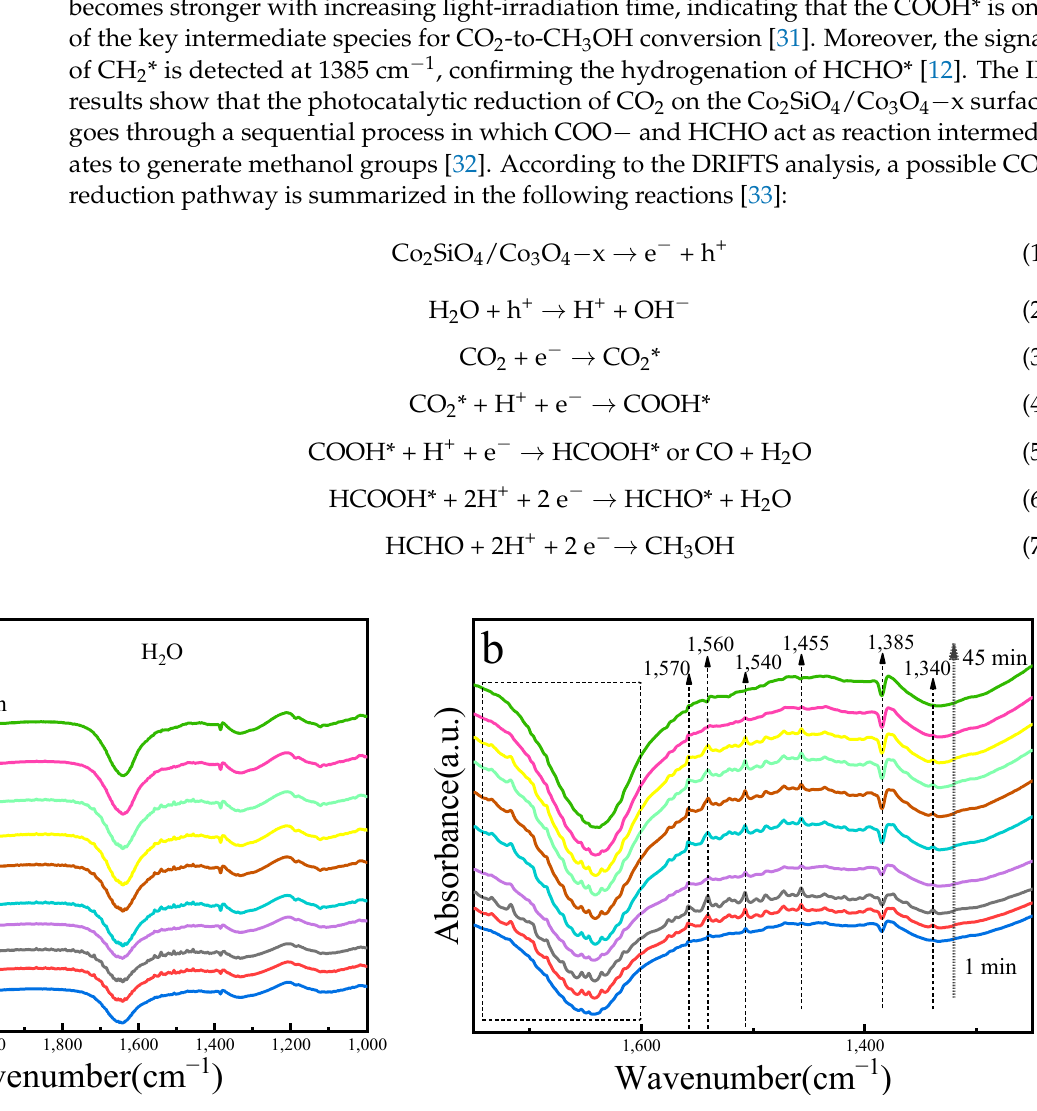
Figure 6. ( a ) In situ DRIFTS spectra for Co 2 SiO 4 /Co 3 O 4 − x; ( b ) enlarged in situ DRIFTS spectra at a wavenumber range of 1,750 − 1,350 cm − 1 .